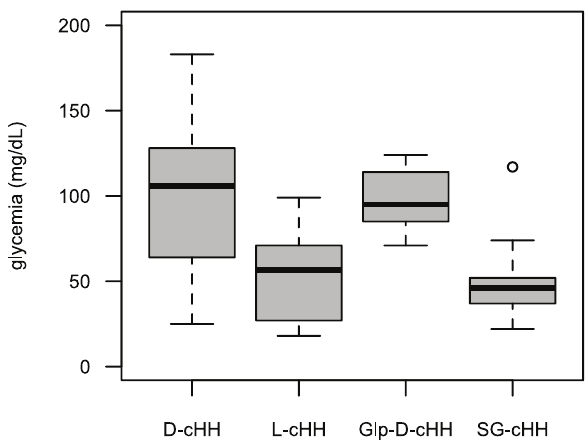
Figure 4. Boxplots of the maximum glucose values recorded for the synthetic and native peptides. Both D-cHH and Glp-D-cHH induced a strong hyperglycemia with a mean peak glucose concentra- tion of, respectively, 100.5 6 9.3 and 98.7 6 6 mg/dL, while the hyper- glycemic effect of GS-cHH and of L-cHH was lower, with a mean of max glycemia of 52.7 6 9.4 mg/dL and of 52.4 6 6.4 mg/dL respectively.